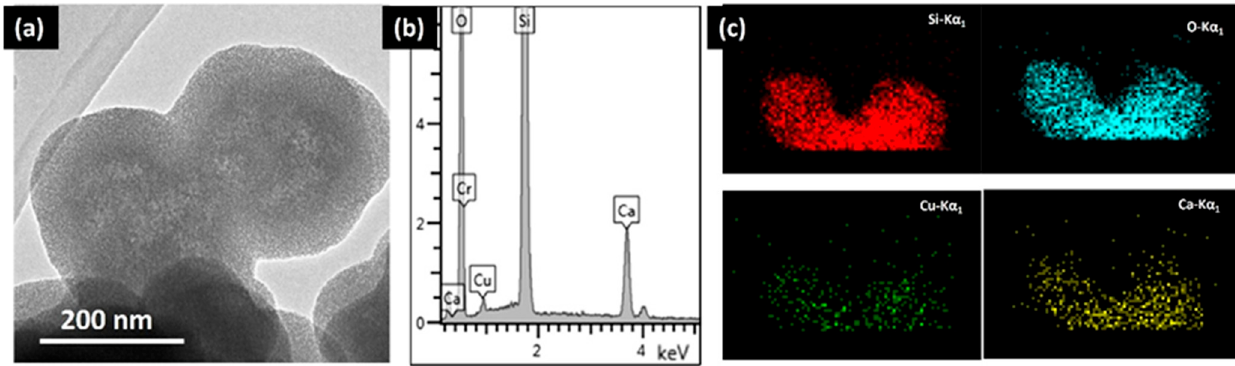
Figure 5. ( a ) TEM image of Cu-MBG 2%; ( b ) EDS spectrum of Cu-MBG 2%; and ( c ) EDS mapping of Cu_MBG 2. Adapted with permission from [53]. Copyright Elsevier (Amsterdam, The Netherlands).